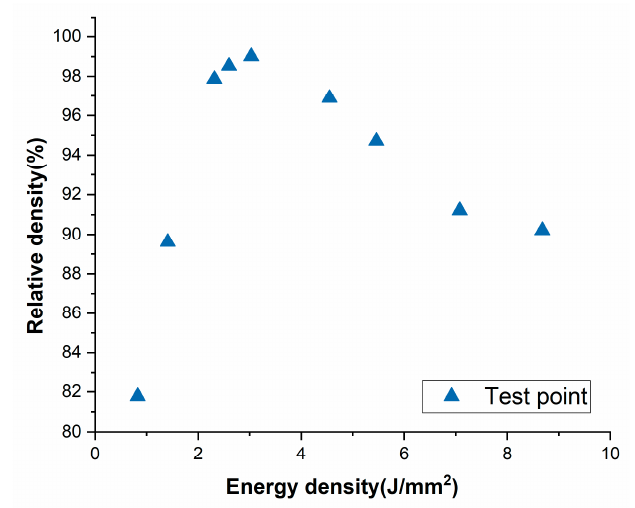
Figure 4. Influence of energy input density on relative density.